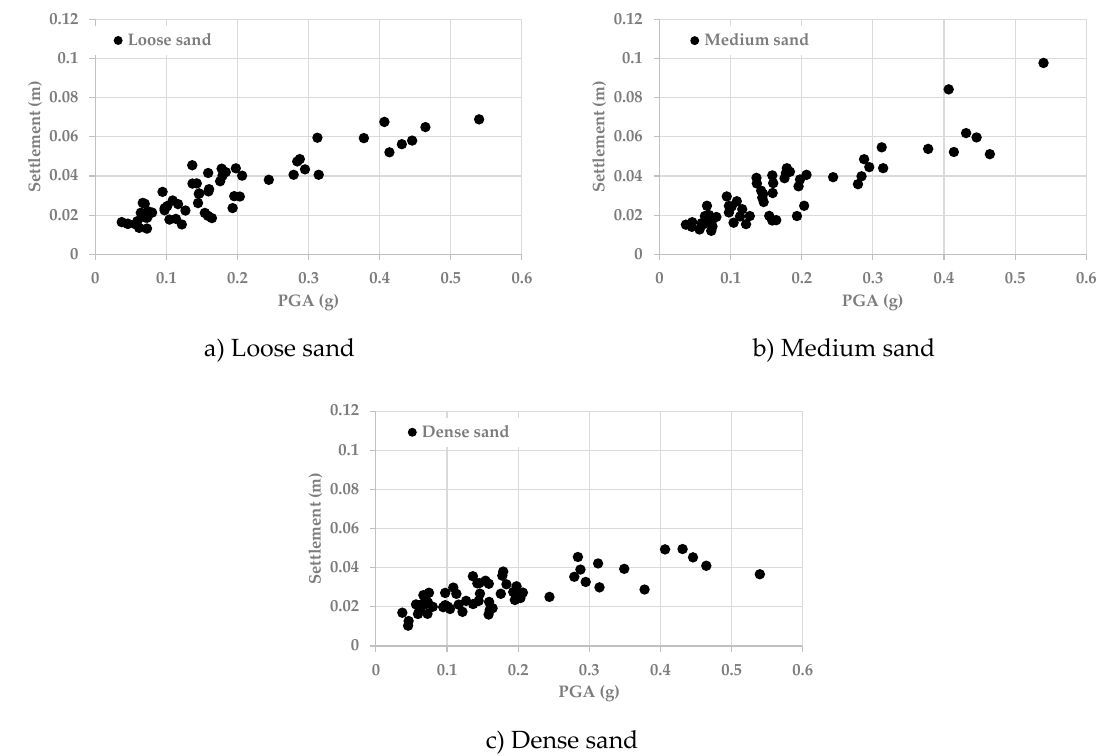
Figure 6. Effect of the PGA and the soil density on the liquefaction-induced seismic settlement.